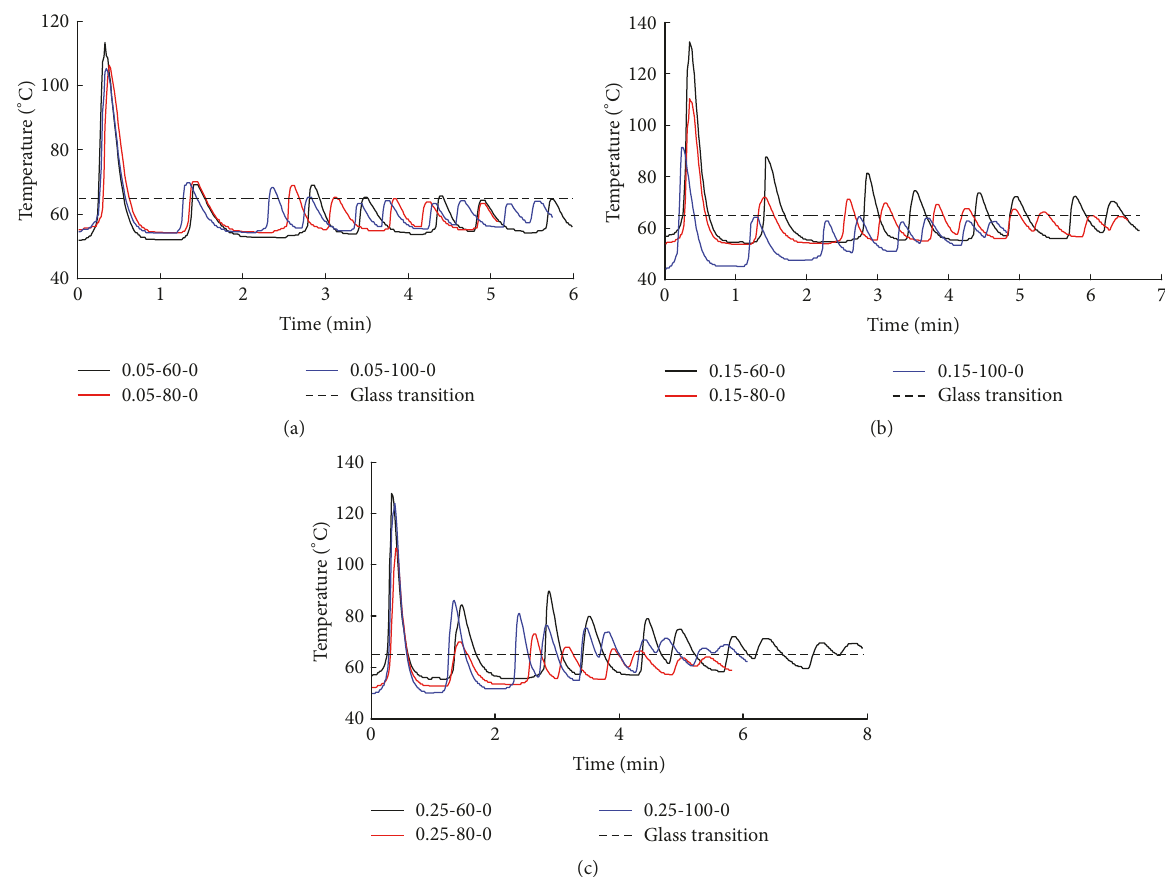
Figure 12: The temperature files under different levels of layer thickness and deposition